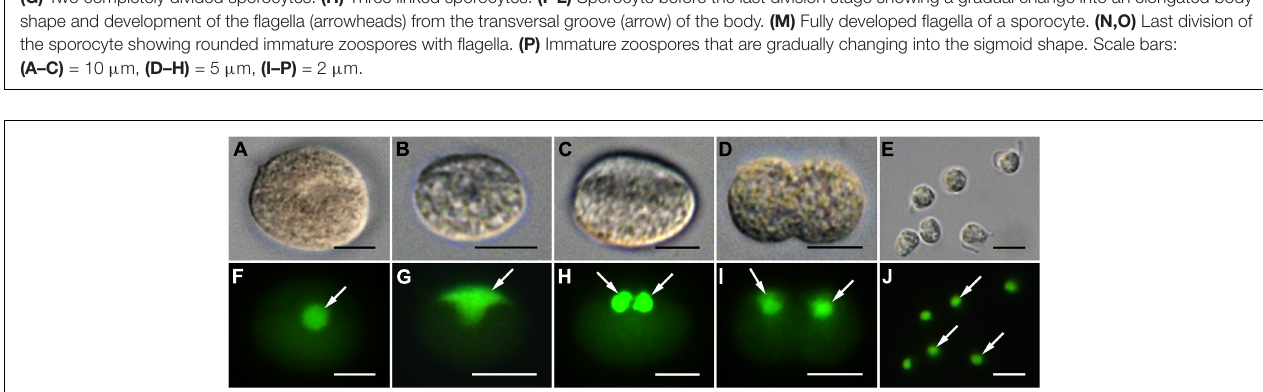
FIGURE 3 | Differential interference contrast (DIC) (A–E) and SYBR gold-stained epifluorescence images (F–J) showing division of the nucleus during sporogenesis stages of Pararosarium dinoexitiosum . The images in each column show the same specimen. (A,F) Sporocyte with a SYBR gold-stained large and rounded nucleus (arrow). (B,G) Sporocyte with laterally positioned T-shape nucleus (arrow). (C,H) Sporocyte showing two completely divided nuclei (arrows). (D,I) Sporocyte showing two nuclei (arrows) separated from each other during cytokinesis. (E,J) Immature zoospore containing a small and rounded nucleus (arrows). All scale bars = 5 µ